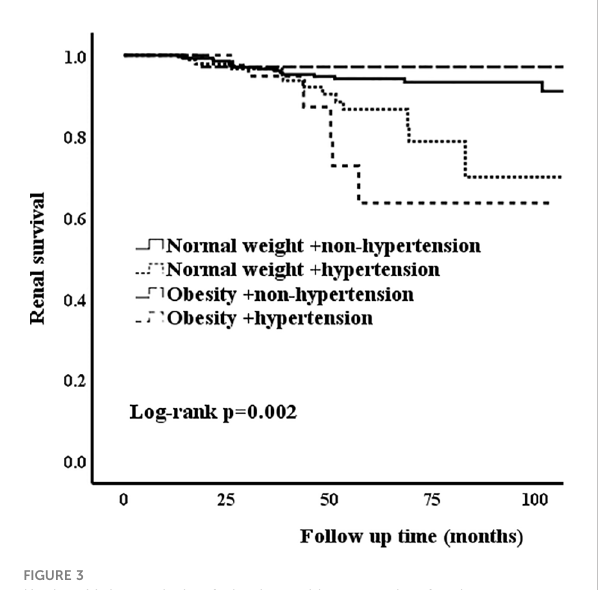
FIGURE 3 Kaplan-Meier analysis of obesity and hypertension for the unmatched patients with 24-h urine protein ≥ 1